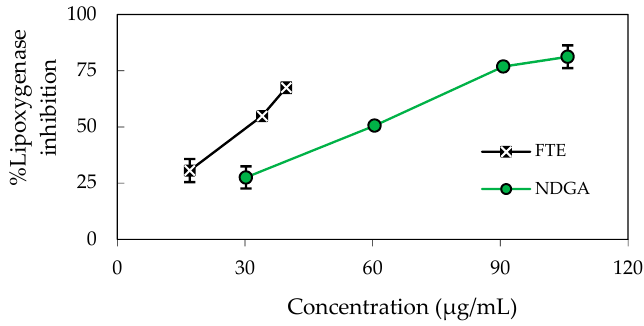
Figure 4. The percent inhibition of soybean lipoxygenase among varying concentrations of the FTE and the positive reference (NDGA). Data are expressed as the mean ± SD ( n = 3).